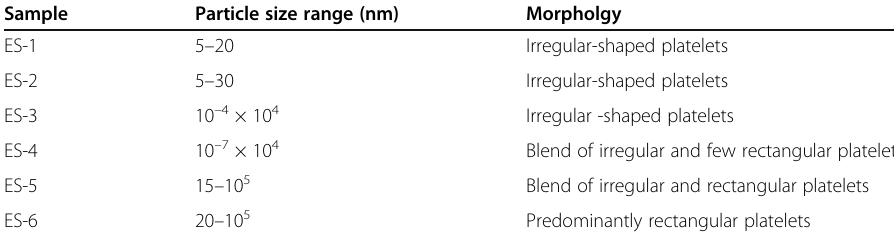
Table 2 Particle size and morphology of bio-CaCO